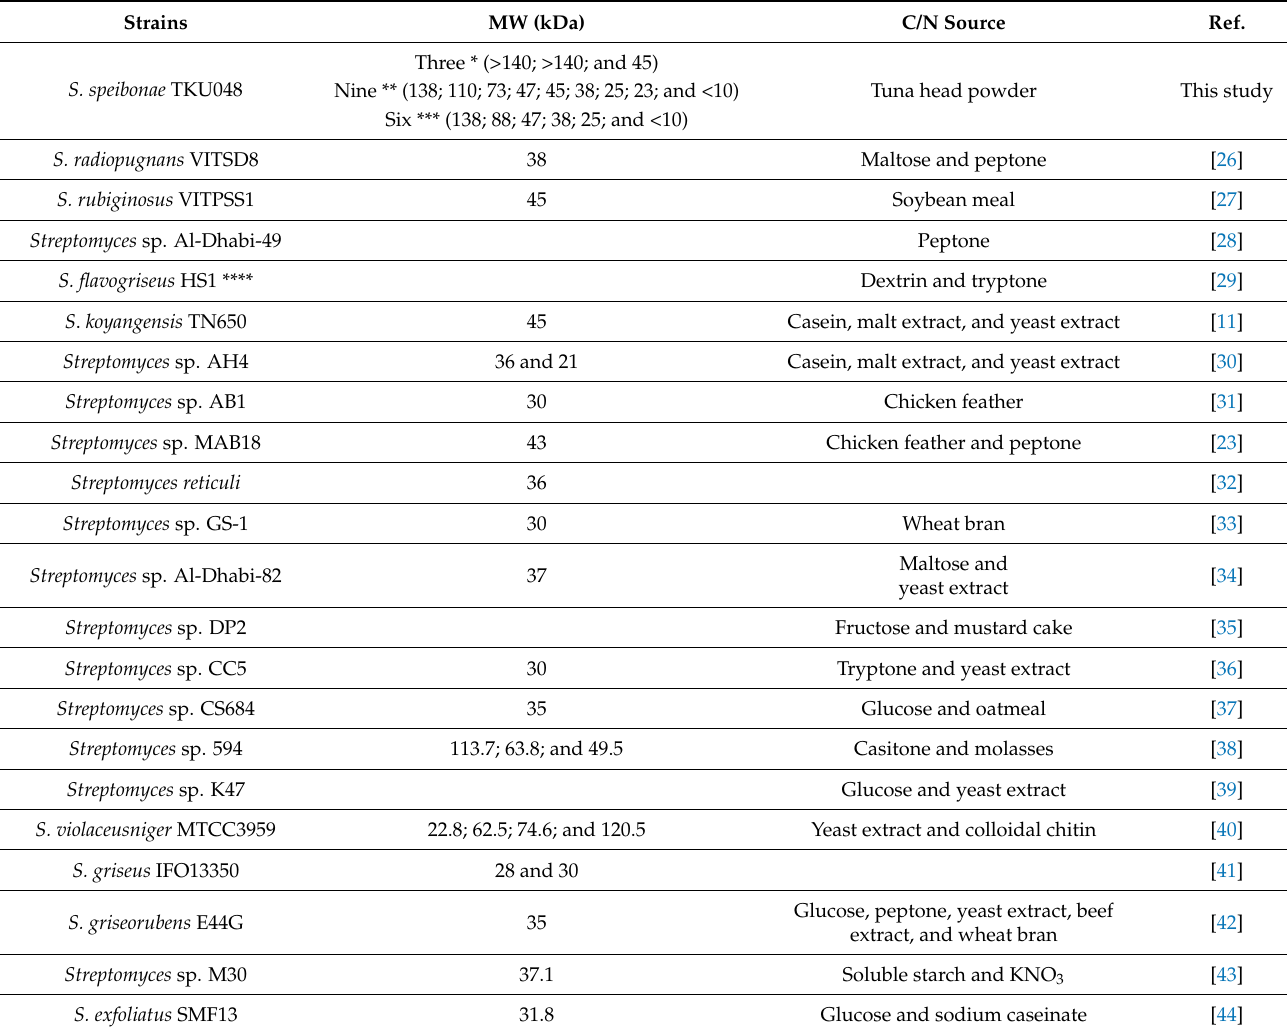
Table 1. A summary of the C/N sources for protease production via Streptomyces strains and molecular weights (MWs) of enzymes